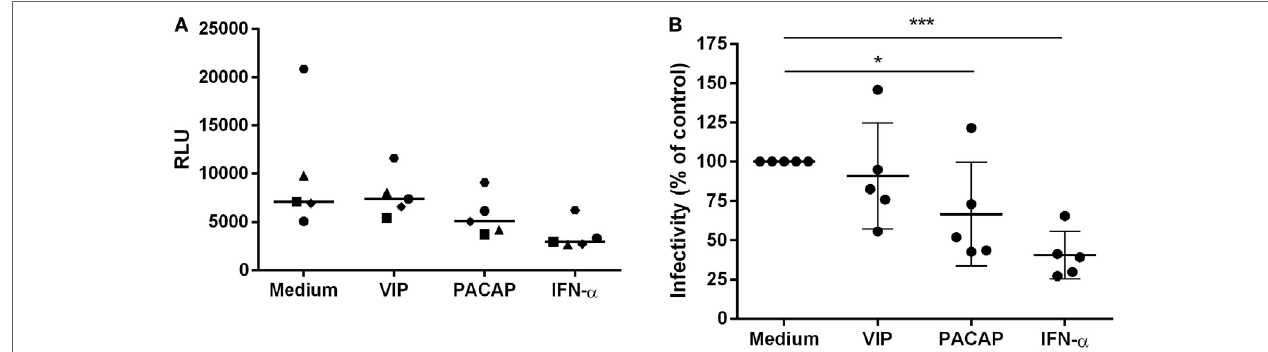
FigUre 8 | Vasoactive intestinal peptide (VIP) and pituitary adenylate cyclase-activating polypeptide (PACAP) reduce HIV-1 replication fitness. TZM-bl cells were exposed to 5 ng/mL of normalized HIV-1 infectious input, obtained from 12 days-infected macrophages treated with VIP (10 nM), PACAP (10 nM), or IFN (10 3 U/mL). After 48 h, TZM-bl cells were lysed and luciferase activity was measured. (a) Relative luminescence units; bars represent the median of each treatment; (B) normalized data from (a) ( n = 5). * p < 0.05; *** p < 0.001; one-way ANOVA, with Dunnett post-test.